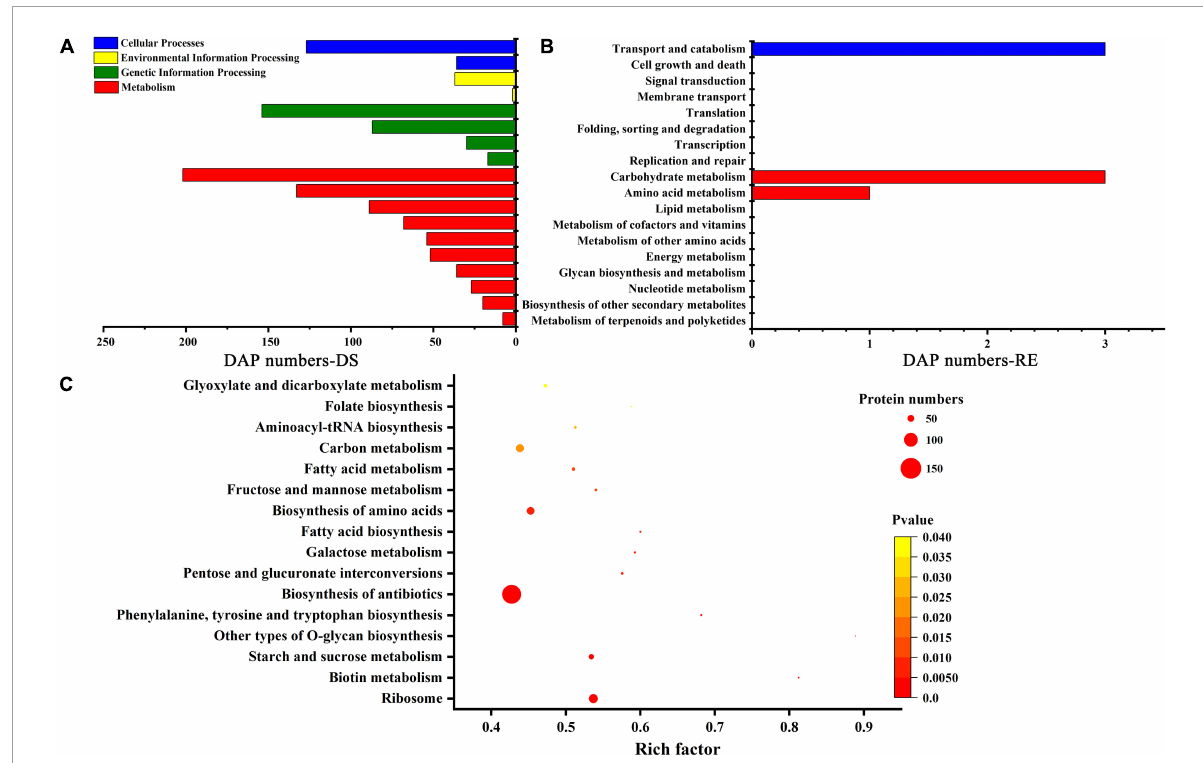
FIGURE3 Kyoto Encyclopedia of Genes and Genomes (KEGG) pathways. (A) KEGG pathways under dessication-stress. (B) KEGG pathways after rehydration. (C) Significantly enriched pathways under dessication-stress. DS, RE, and DAP represent dessication-stress, rehydration, and differentially abundant protein, respectively.